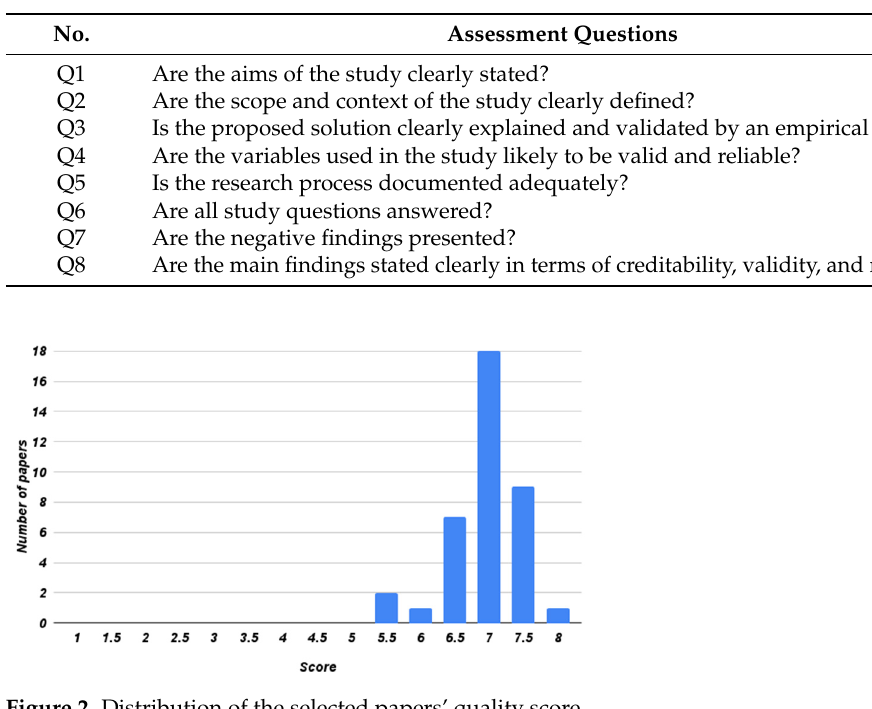
Figure 2. Distribution of the selected papers’ quality score.